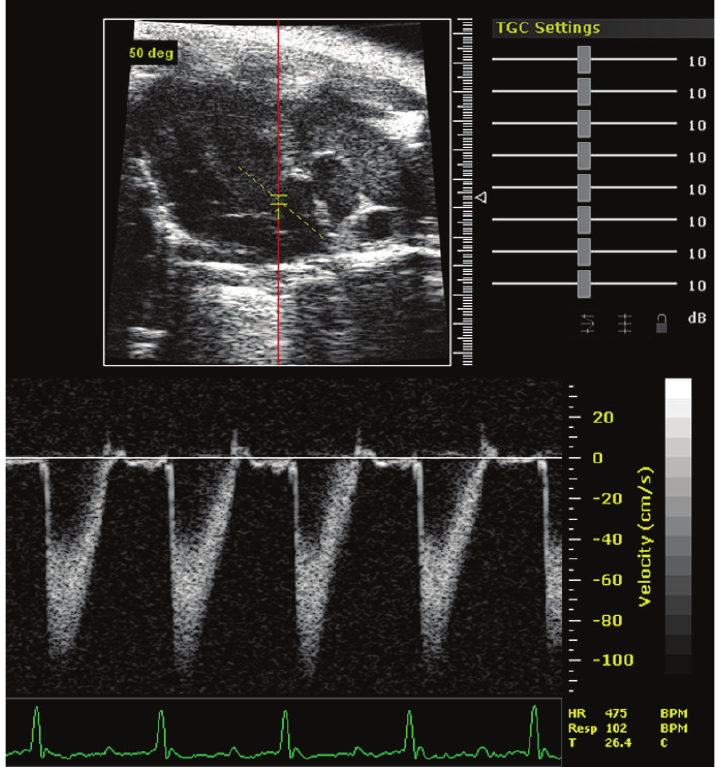
Figure 2: Aortic pulse Doppler tracings obtained on a wild-type